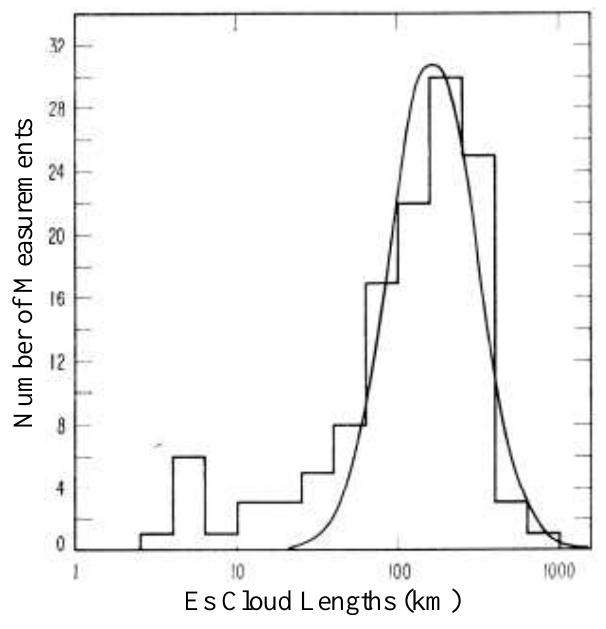
Figure 1: Histogram of E s lengths, at 7 . 22 MHz, with a log normal fit to the longer dimensions. The fit has its peak Fig. 1. Histogram of E s lengths, at 7 . 22MHz, with a log normal at 170 km, and approximately 68% of the area under the fit to the longer dimensions. The fit has its peak at 170km, and curve lies in the interval 94 km to 310 km. Reproduced approximately 68% of the area under the curve lies in the interval from Cathey [1969]. 94km to 310km. Reproduced from Cathey